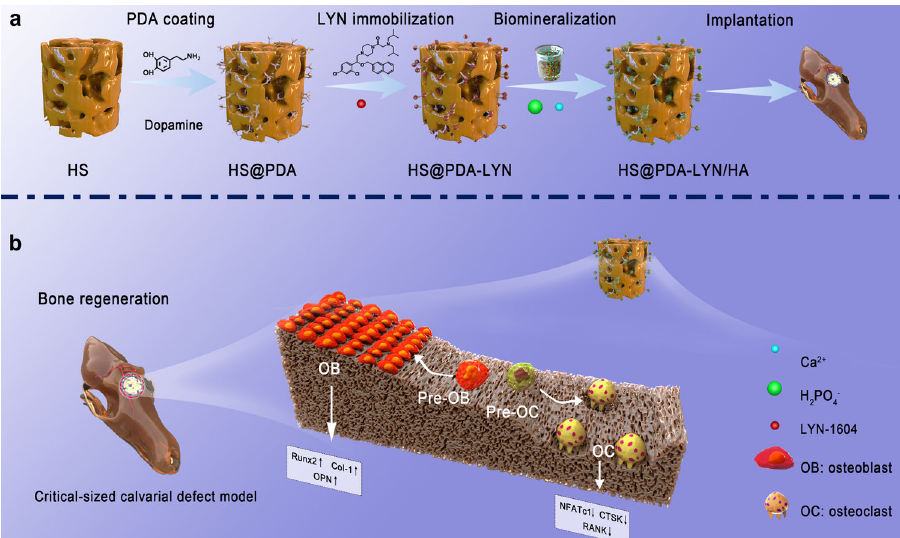
Fig. 1 Schematic illustrations of the construction and application of multifunctional nanocomposite scaffolds. a The HS@PDA-LYN/HA scaffold was fabricated via a bioinspired PDA intermediate, followed by sequential immobilization of LYN and HA. b The dual biological function of HS@PDA-LYN/HA facilitated endogenous bone regeneration through osteogenic stimulation and osteoclastic